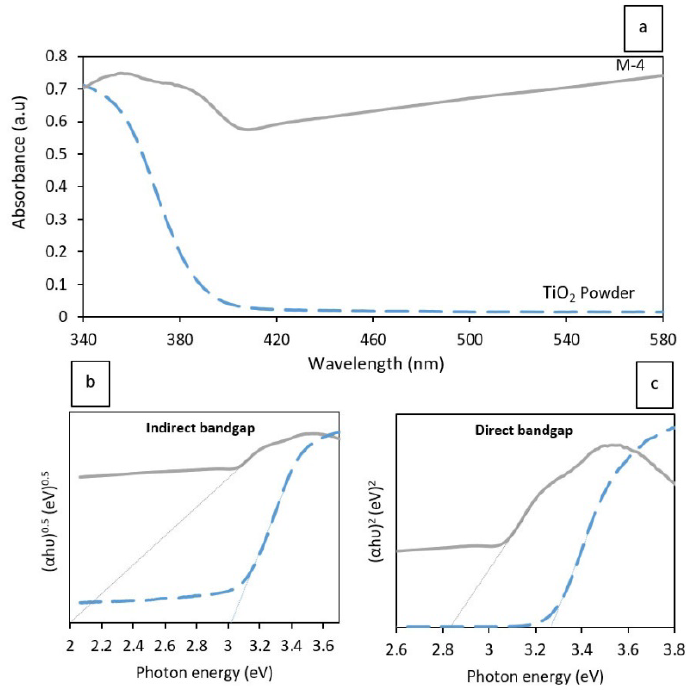
Figure 13. ( a ) UV–vis absorption spectra, ( b ) ( α h ν ) 0.5 -h ν , and ( c ) ( α h ν ) 2 -h ν plots of TiO 2 feedstock powder and M-4 membrane.